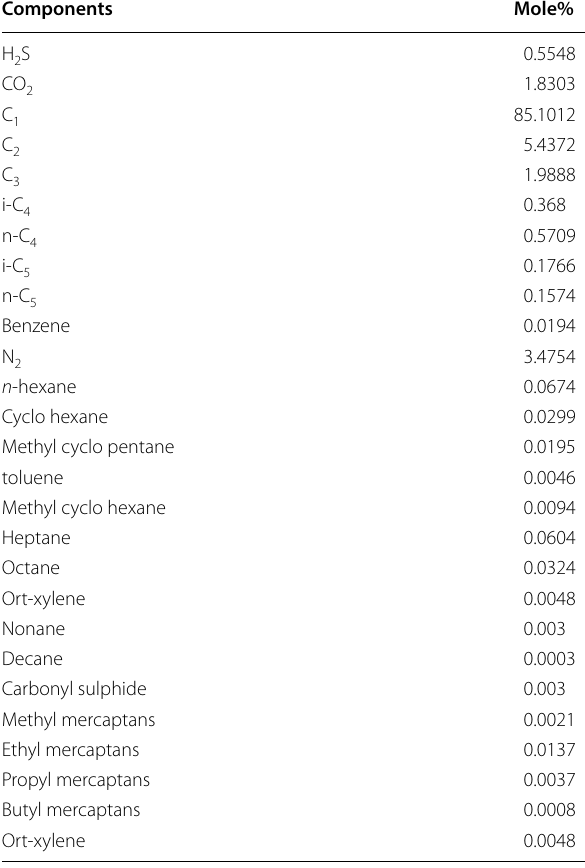
Table 1 Characteristics of sour gas feed to the gas sweetening unit (units 101 and 108) of phases 2 and 3 in South Pars Gas Field (Asalouyeh, Iran)